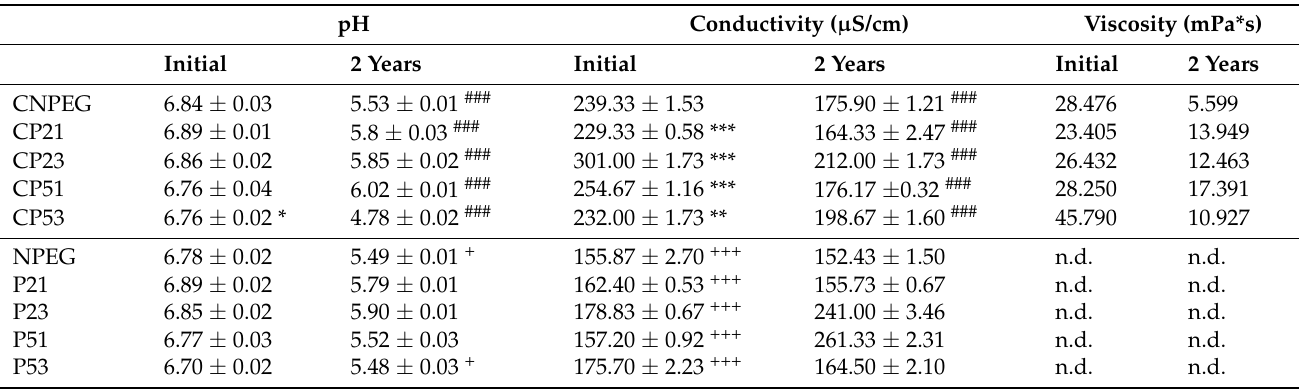
Table 5. Values of pH, conductivity and viscosity for curcumin-loaded and placebo nanoemulsions measured initially and after two years of storage at room temperature.